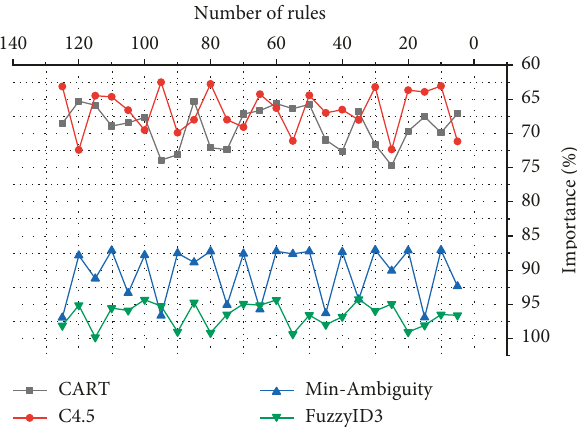
Figure 8: Importance of algorithms to the implementation phase of internal audit.